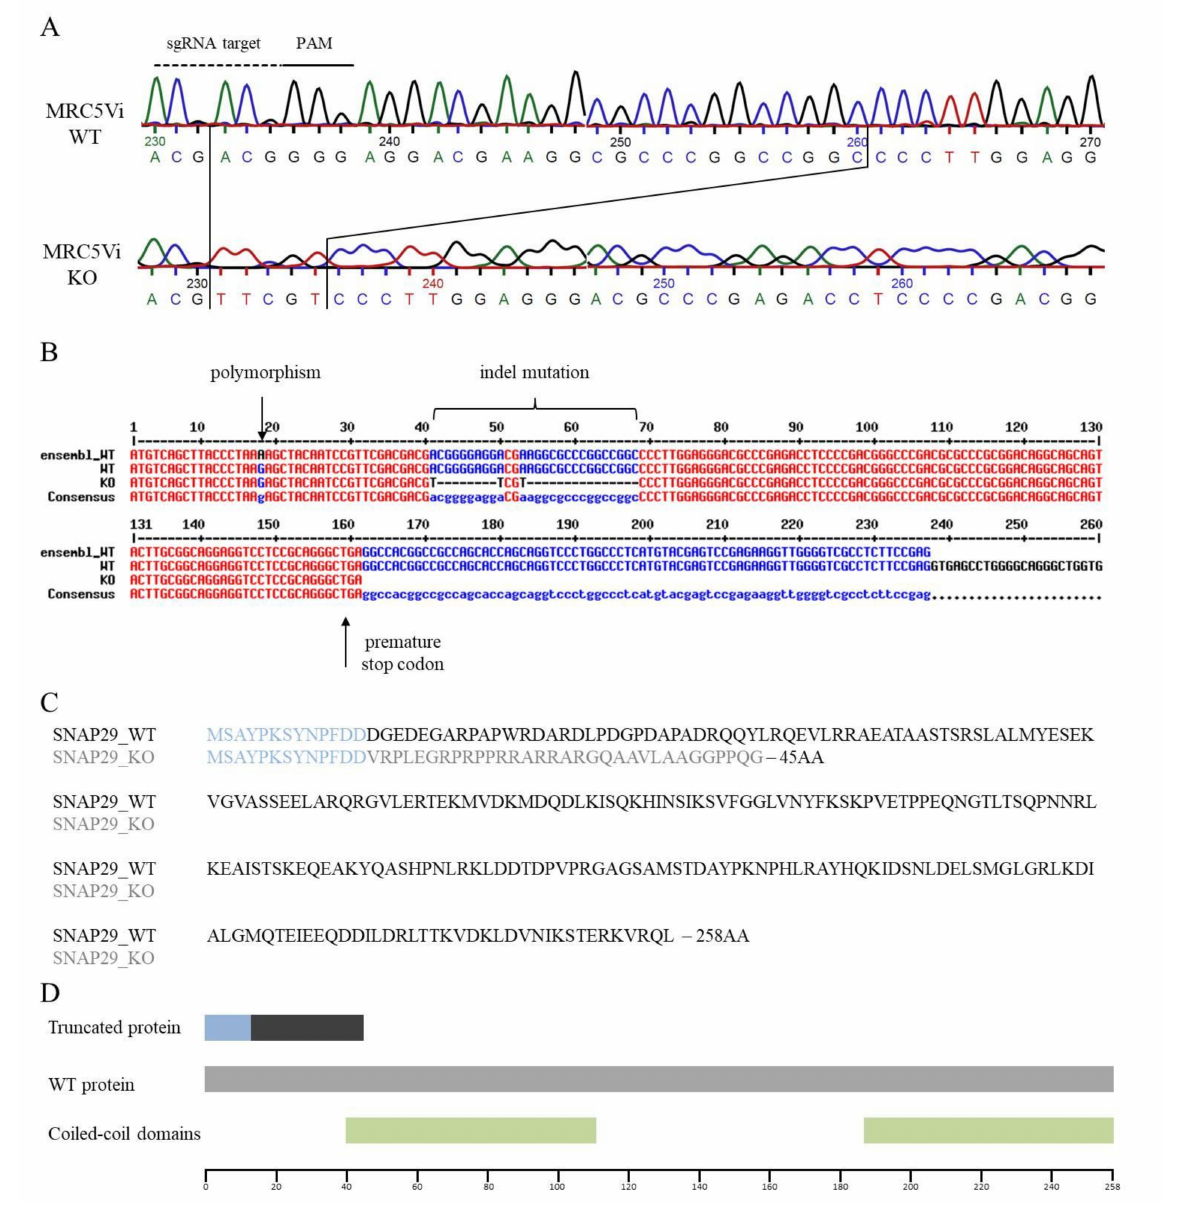
Figure 3. Sequencing analysis of a SNAP29 knockout (KO) cell line compared to wildtype (WT). ( A ) The SNAP29 KO fibroblast clone was sequenced by Sanger sequencing and compared to the WT MRC5Vi DNA sequence. The sgRNA target and the PAM sequence are highlighted. Sequence comparison showed an indel mutation, in exon 1 (c.41_68delinsTTCGT). ( B ) Further comparison showed a polymorphism on position 18 of the used MRC5Vi fibroblasts using the DNA sequence from the database Ensembl (https://www.ensembl.org, accessed on 11 November 2018) as a reference. ( C ) Comparison of the resulting protein sequence: identical sequences are shown in light blue (13 amino acids). The modified protein sequence from the KO clone is shown in light gray (32 amino acids). The resulting truncated protein contains 45 amino acids in total. ( D ) Position of functional coiled-coil domains of SNAP29: the truncated protein is presented in the colors as mentioned